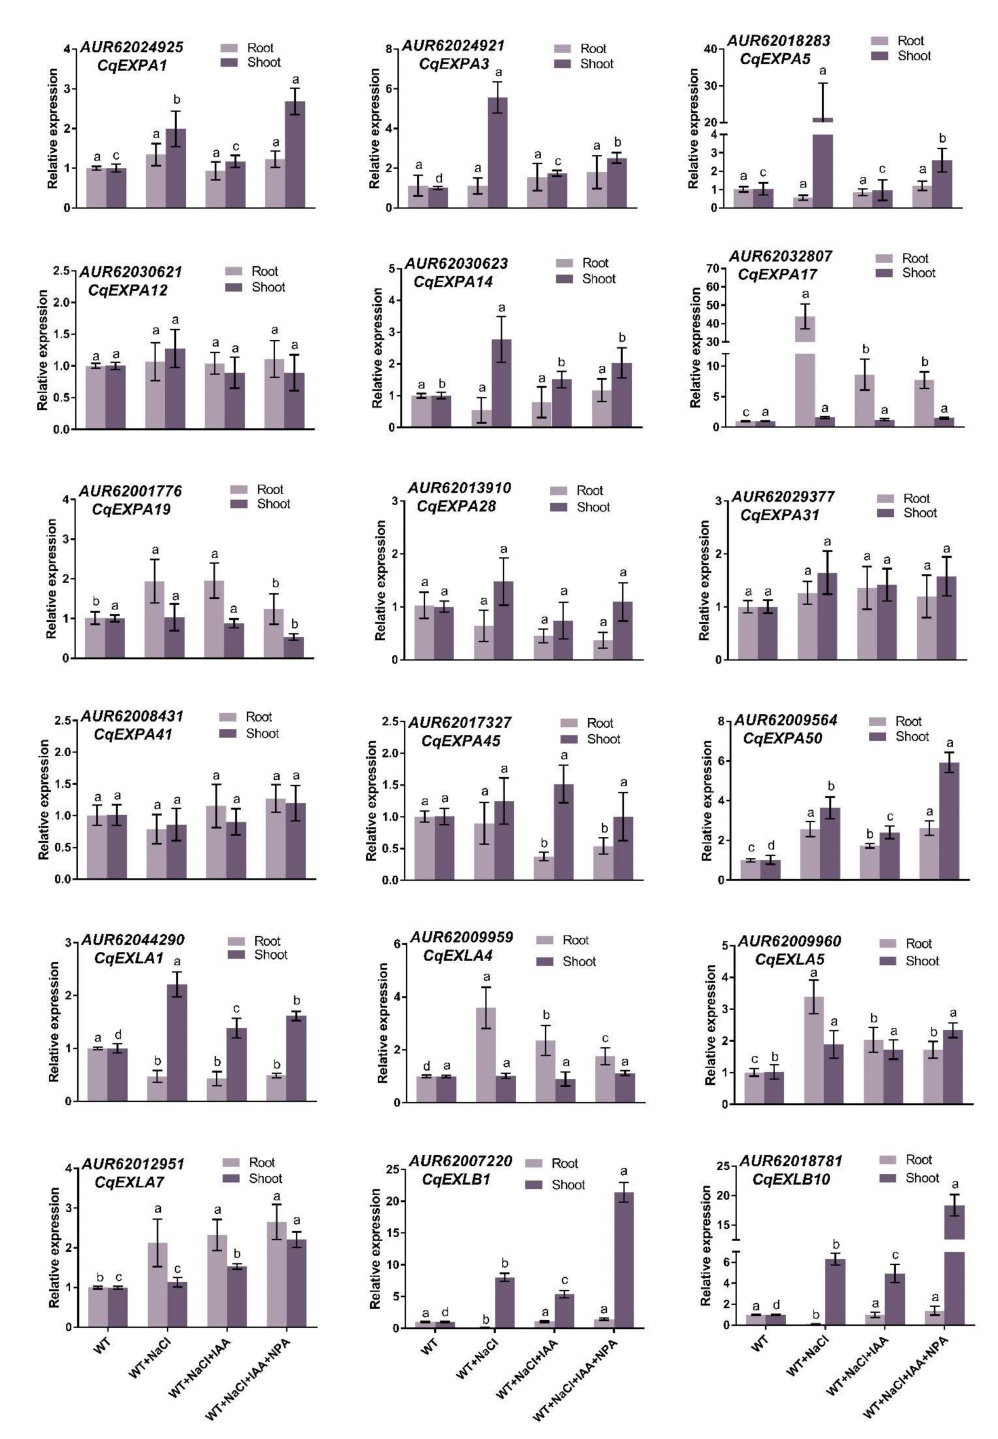
Figure 3. Effects of IAA and NPA on the expressions of Cqexpansin genes in quinoa root and shoot under salt stress. Quinoa seedlings of six true leaves were cultured in Hoagland solution (CK), 150 mM NaCl-Hoagland solution, 150 mM NaCl + 3 µ M IAA-Hoagland solution and 150 mM NaCl + 3 µ M IAA + 7 µ M NPA-Hoagland solution for two weeks, and then qRT-PCR was used to detect the expression of different genes. Values are mean ± SD ( n = 3). Different letters (a–d) in Figure 3 indicate significant differences at p < 0.05 according to one-way ANOVA (comparing the mean of each column with the mean of every other column) in GraphPad Prism